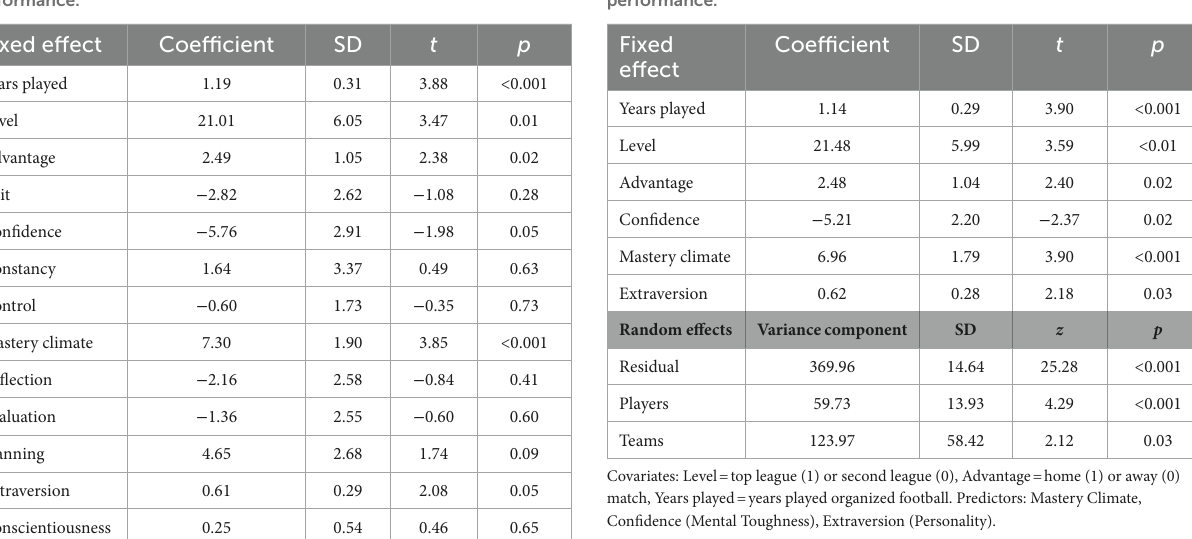
TABLE 4 Linear mixed model, final model for predicting football